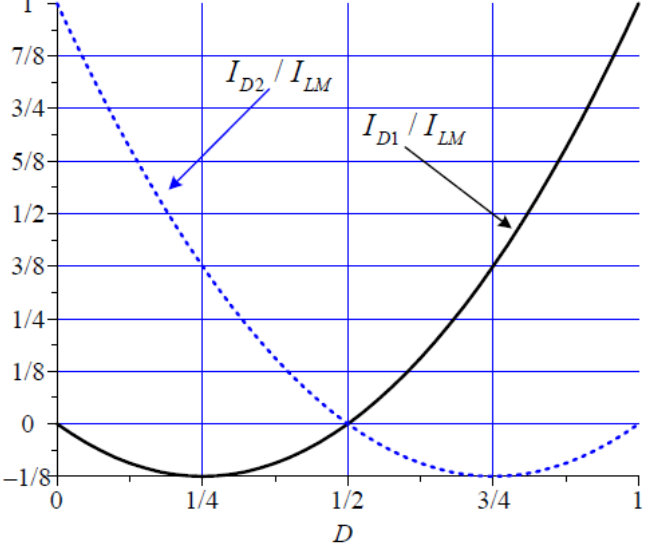
/ I / I LM and I D 2 LM with respect to D